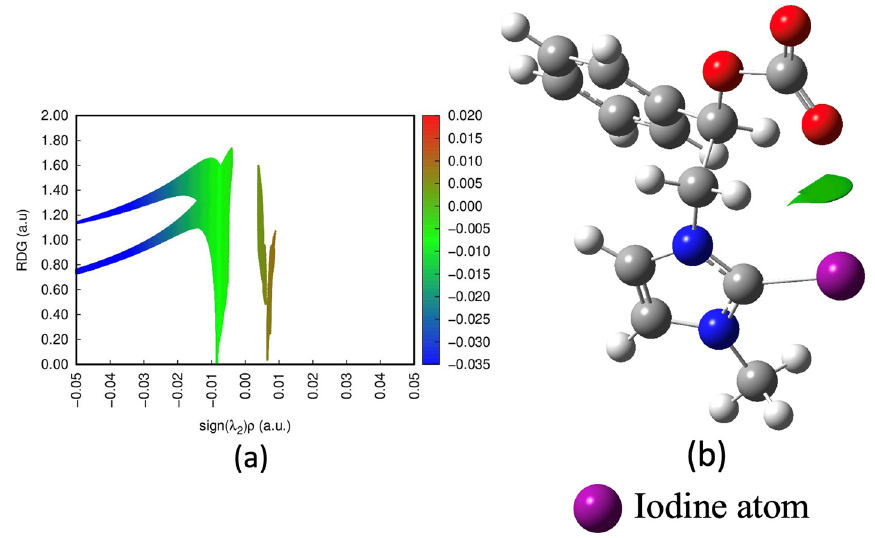
Figure 8. ( a ) The Reduced Density Gradient (RDG) scatter graph representing the NCI of I1 2I-1M- HIm shown in Figure 8b. ( b ) Visual representation of the NCI as a green surface.